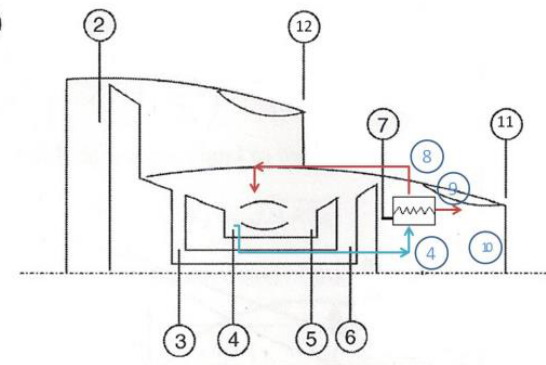
Figure 1: Layout of a two-spool turbofan engine with regenerator (Adapted from [11]) as function of the BPR. The layout of the engine and sta- tions numbering is presented in Figure